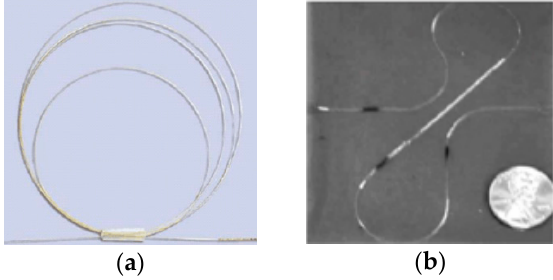
Figure 4. Fiber Bragg grating (FBG) sensor ( a ) and FBG strain rosette ( b ).